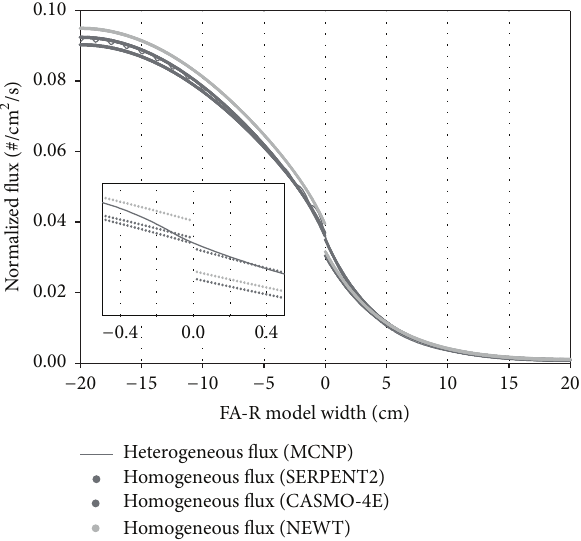
Figure 10: The thermal flux distribution and detail view at interface for FA-R